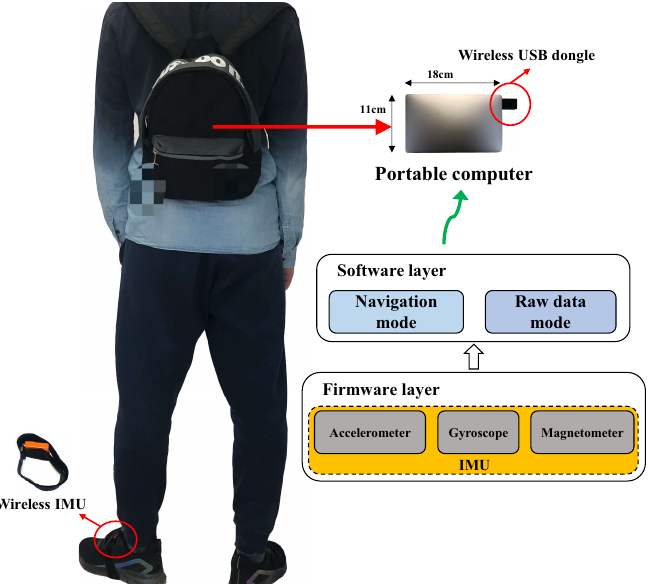
Figure 4. Wearable PNS: The proposed two-layer software framework was deployed to a portable computer. The framework included firmware and software layers. The wireless inertial measurement unit (IMU) was driven by the firmware layer and connected with the computer via a wireless USB dongle. The system could be configured to output raw sensor data (raw data mode) or output the position, velocity, and attitude (navigation mode) by the software